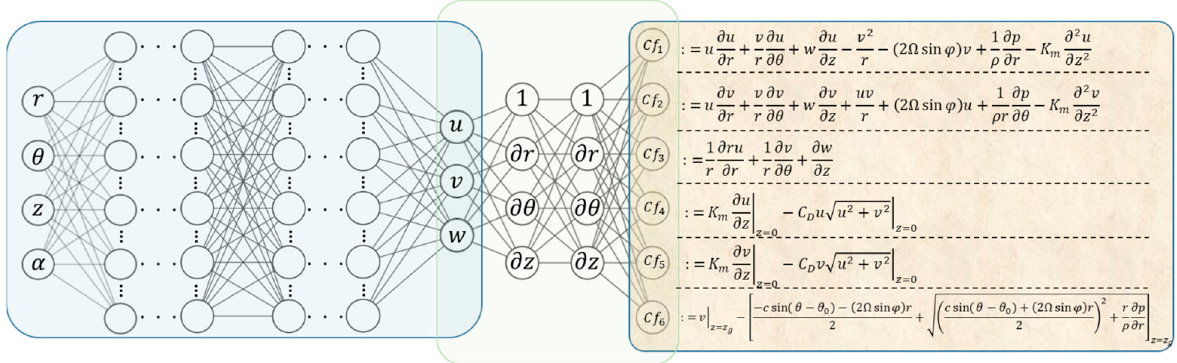
Figure 3. Knowledge-enhanced deep network architecture for ETC.